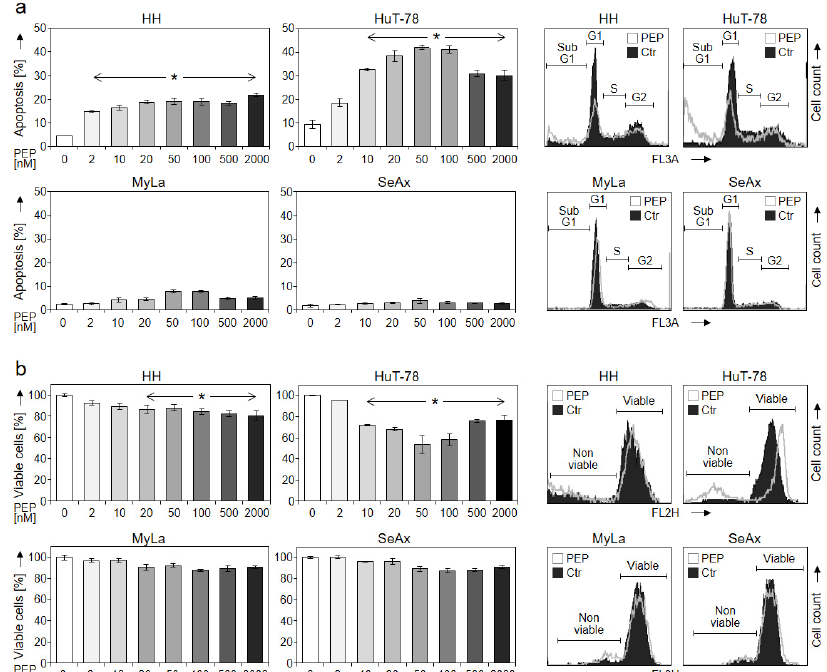
Figure 1. Dose dependency of induced apoptosis and decreased cell viability. Apoptotic rates (propidiumiodide staining, a ) and cell viability (calcein staining, b ) were determined in four CTCL cell lines (HH, HuT-78, MyLa and SeAx) treated for 48 h with increasing concentrations of PEP005 (2, 10, 20, 50, 100, 500, 2000 nM). Apoptotic rates correspond to percentages of cells with fragmented DNA, which were determined as sub-G1 cells. Cell viability values are shown in relation to non-treated controls, which were set to 100%. Characteristic histograms of cells treated with 50 nM PEP005 (PEP) are shown on the right side in overlays with control cells (Ctr). Cell populations in cell cycle phases G1, S, G2 and sub-G1 cells as well as viable and non-viable cells are indicated in ( a , b ), respectively. Mean values of triplicates ± SDs of representative experiments are shown. At least two independent experiments (each one with triplicates) revealed highly similar data. Statistical significance was calculated from all values (at least 6) and is shown for treated cells vs. controls (* p <